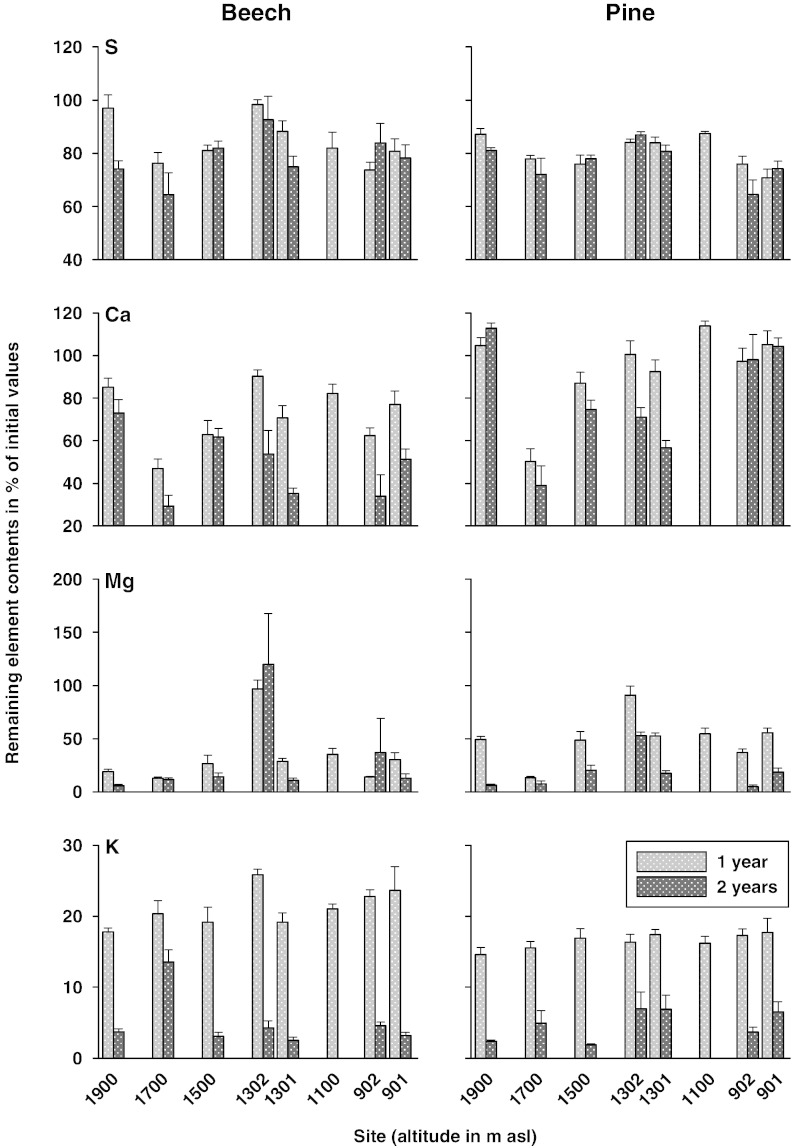
Remaining contents of S, Ca, Mg and K (percent of initial values) of exposed beech and pine litter at the eight study sites along an elevation gradient after 1 and 2 years. Data are given as means with standard error (N = 5).